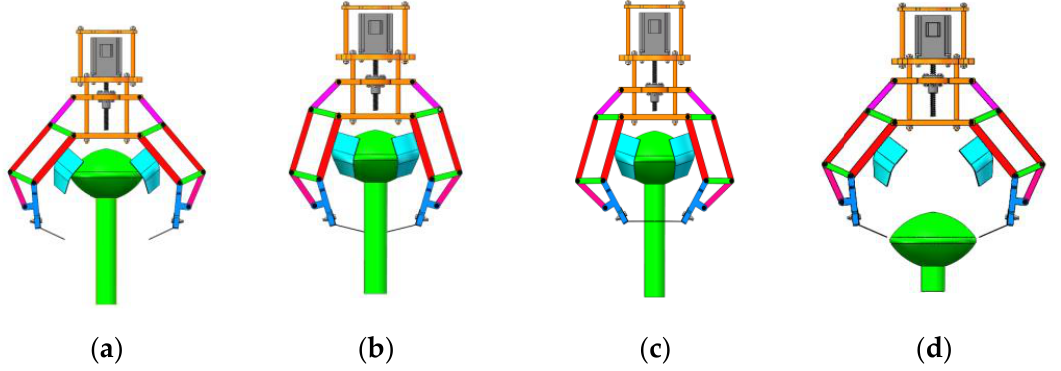
Figure 3. Working principle diagram of picking manipulator: ( a ) The manipulator enters the area to be picked, ( b ) Envelope flower ball, ( c ) Clamp – cut flower ball, and ( d ) Release flower ball.